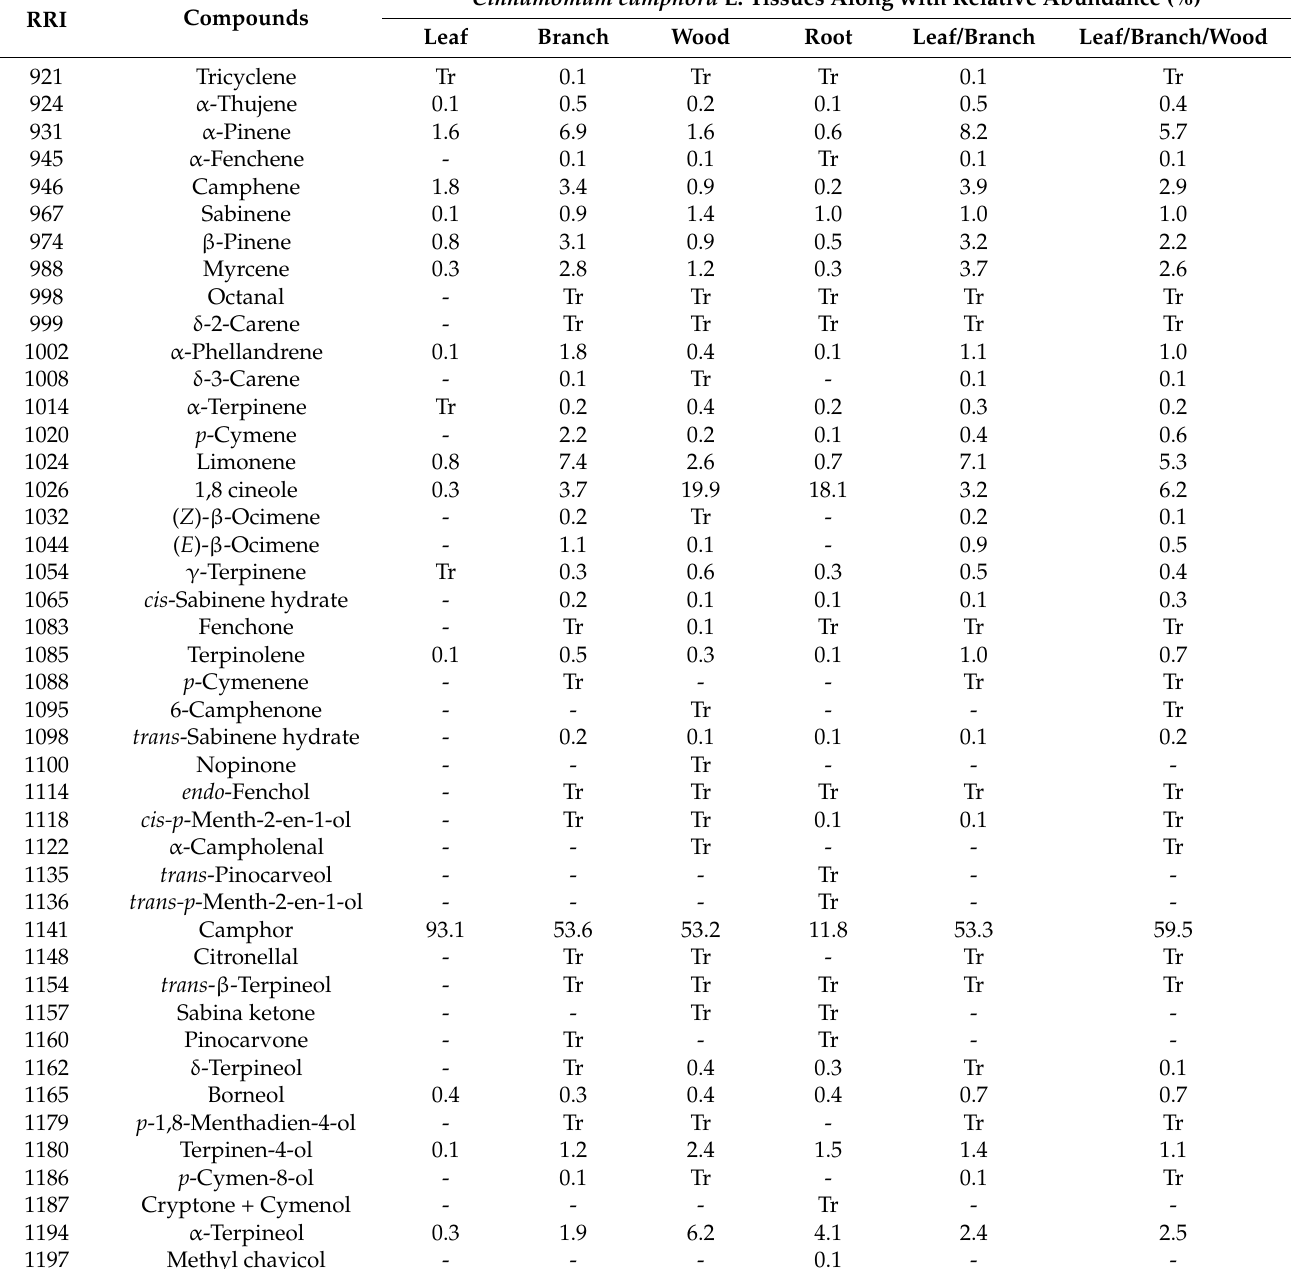
Table 2. Essential oil compositions of Cinnamomum camphora L. (Tr indicates trace,